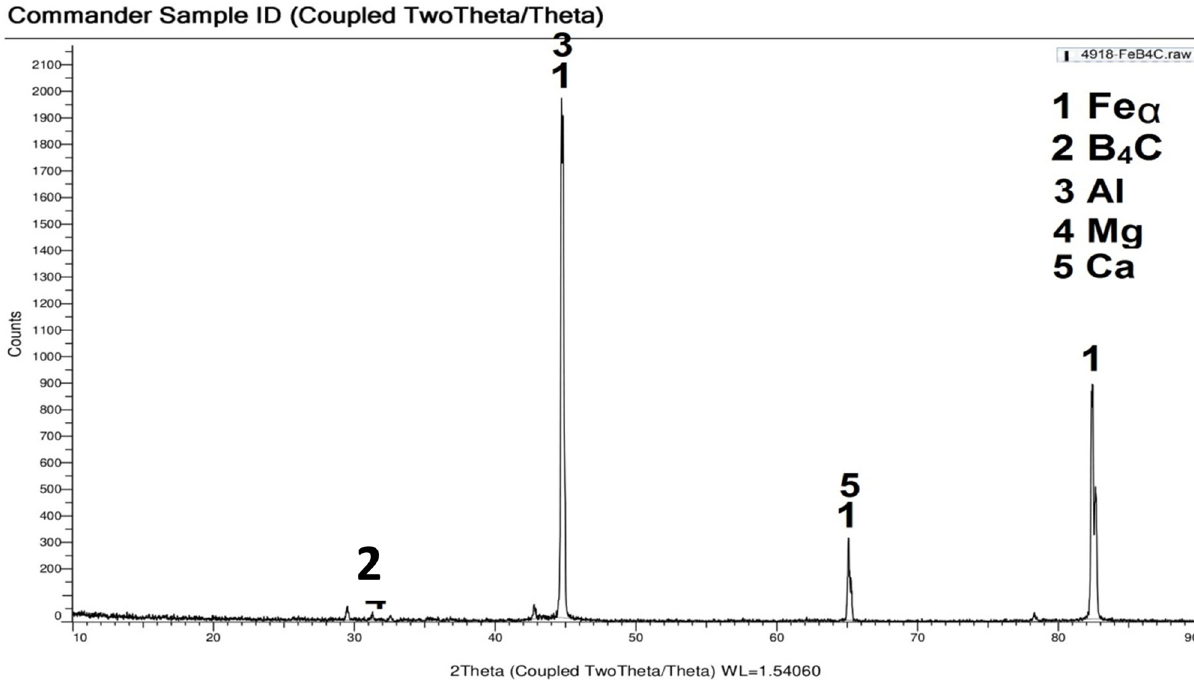
Figure 10: XRD analysis of 98.33% Fe – 1.66% B 4 C composite.